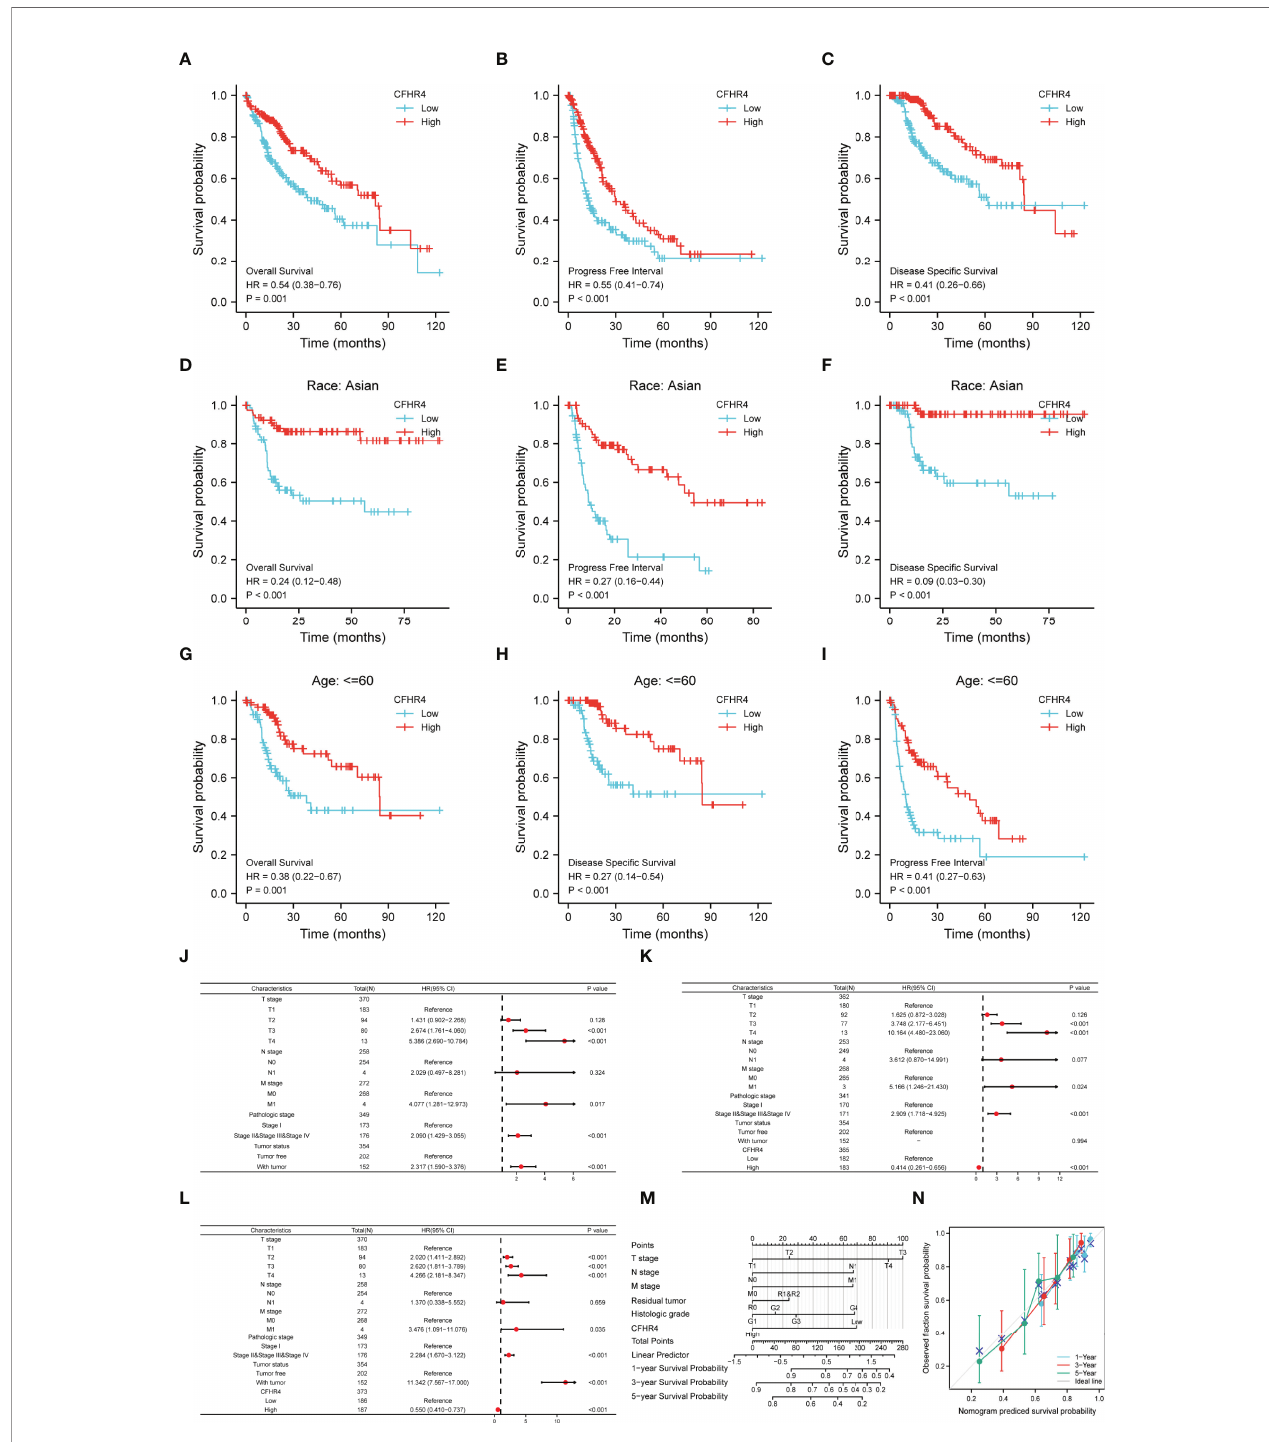
FIGURE 6 | The prognostic value of CFHR4 in HCC. (A – C) Survival curves showing a comparison of OS, DSS and PFI between patients with HCC presenting high and low CFHR4 expression. (D – F) OS, DSS and PFI survival curves for Asian patients with HCC presenting high and low CFHR4 expression. (G – I) OS, DSS and PFI survival curves for patients with HCC aged ≤ 60 years presenting with high and low CFHR4 expression. (J – L) Univariate survival analysis of OS, PFI, and DSS in patients from different subgroups strati fi ed according to TNM stage, pathological grade, tumor status, and CFHR4 expression levels. (M) For patients with HCC, a nomogram was constructed to estimate the probability of 1-, 3-, and 5-year OS. (N) Nomogram calibration plots for determining the probability of OS at 1, 3, and 5